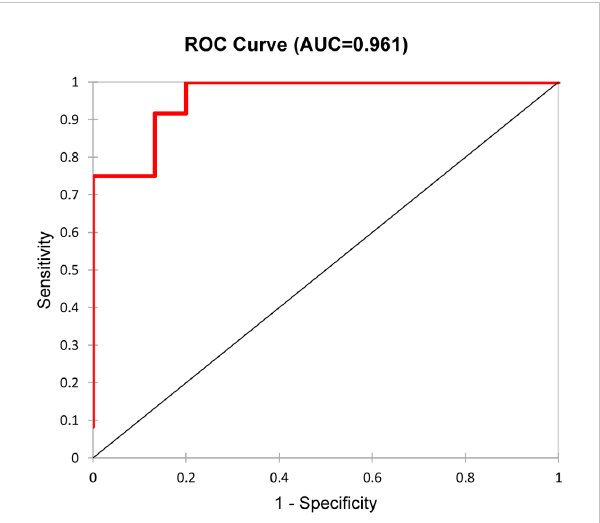
FIGURE 4 Differentiation of the two groups (favourable and